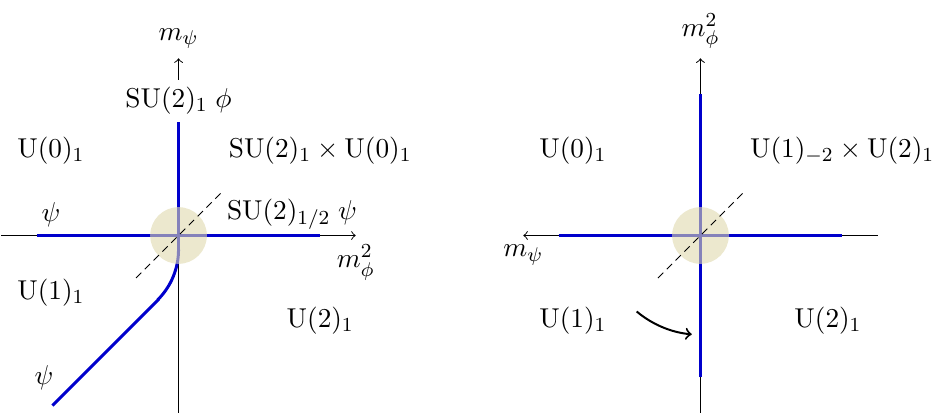
Figure 3 . SU(2) 1 with φ, ψ U(1) − 3 with φ, ψ U(1) 1 . Phase diagram. On both sides we / 2 / 2 ←→ × emphasized an emergent time-reversal symmetry (with an anomaly) with respect to the dashed